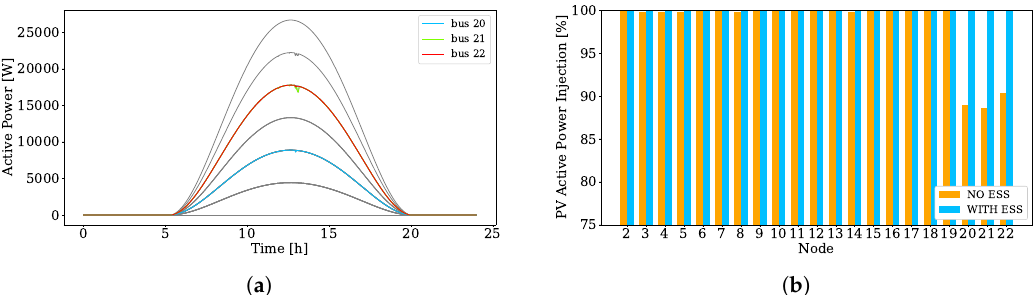
Figure 9. Distributed control applied to both Distributed Generation (DG) and Energy Storage Systems (ESSs). ( a ) Active power generated by PVs ( b ) Percentage level of PV energy